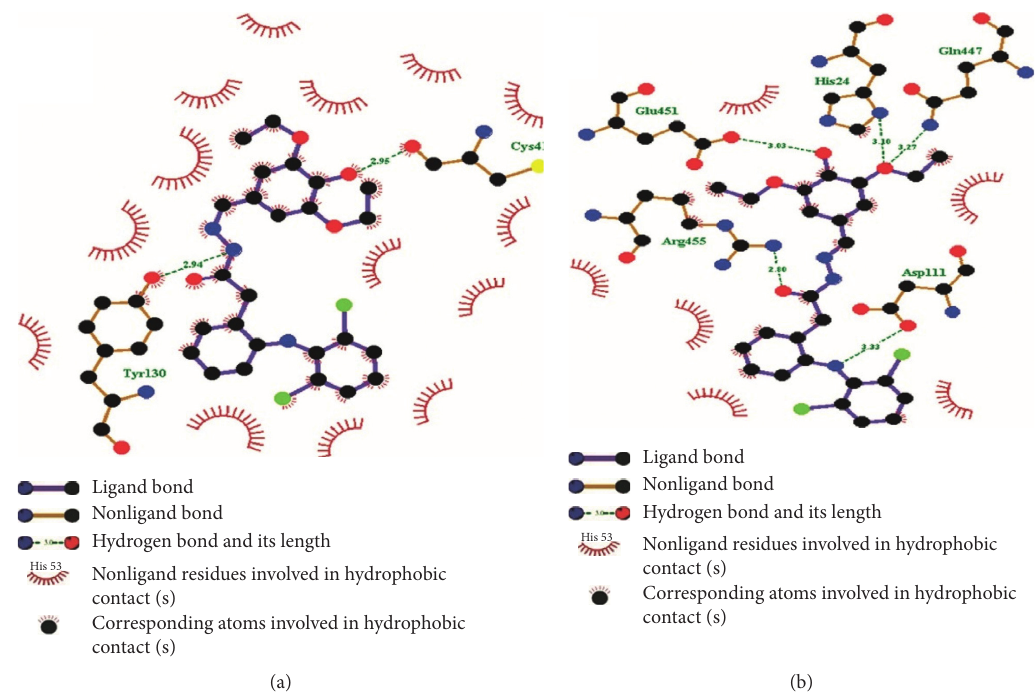
Figure 5: 2D representation of binding of compound 8 with COX-1 and COX-2. (a) Binding of compound 8 with COX-1 amino acid residues. It can be seen that compound 8 is making hydrogen bonds with Try-130 and Cys-41 (green dotted line) while the majority of interactions are hydrophobic in nature. (b) Binding of compound 8 with COX-2 amino acid residues. It can be seen that compound 8 is making hydrogen bonds with Asp-111, Glu-451, Gln447, Arg-455 Arg-445 (green dotted line) while majority of interactions are hy- drophobic in nature.